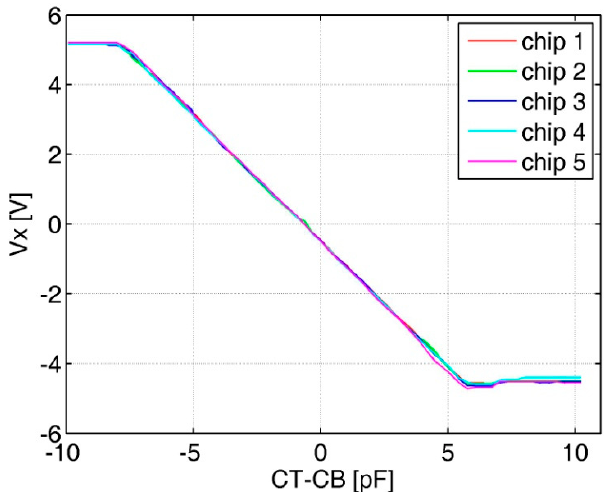
Figure 8. Analog front-end test results with the on-chip programmable capacitor.